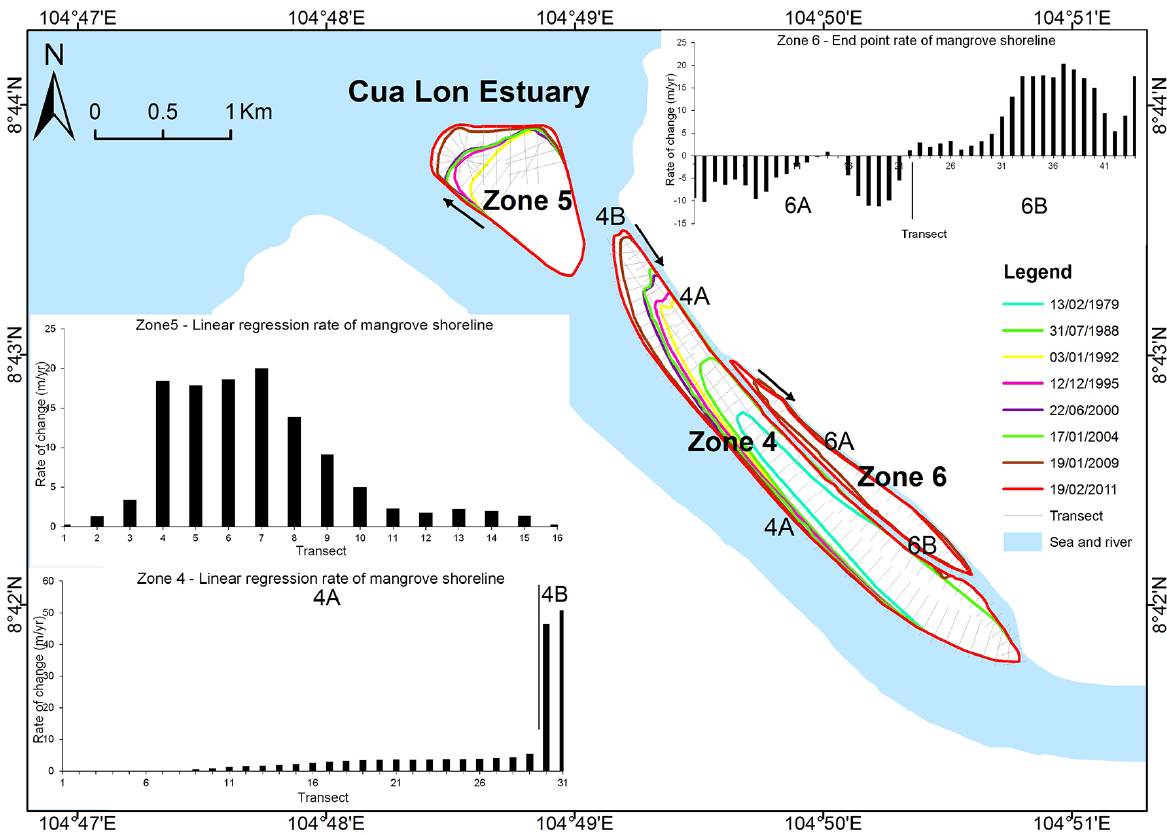
Figure 4. Mangrove shoreline change in zone 4 (Con Trong), zone 5 (Con Ngoai) and zone 6 (Con Moi) in the Cua Lon Estuary. These are new islands were formed in the 1960s, 1980s, and 2000s, respectively. Therefore, 8, 5 and only 2 mangrove shorelines were generated for zone 4, zone 5 and zone 6, respectively. DSAS software generated 74, 16 and 44 transects for zone 4, zone 5 and zone 6, respectively. Zone 4 and zone 6 each is divided into two dynamic regions, A and B. The arrows show the direction of transects from 1 to 74 for zone 4, from 1 to 16 for zone 5 and from 1 to 44 for zone